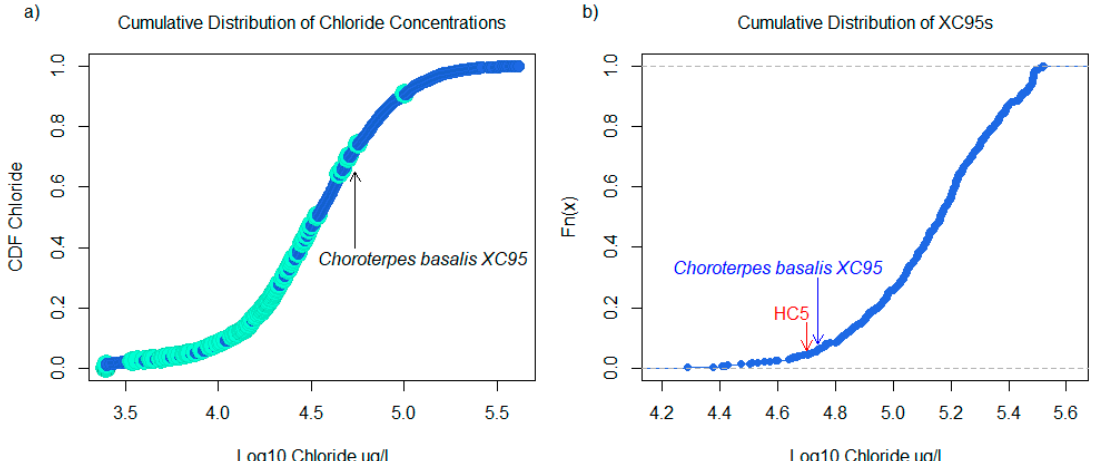
Figure 2. ( a ) The cumulative distribution of chloride concentrations from all sites. Site where the mayfly Choroterpes basalis occurs are highlighted in aquamarine and with a larger point size. The 95th percentile chloride concentration specific to C. basalis is noted as the XC95. ( b ) Cumulative distributions of XC95s for all taxa, with the XC95 for C. basalis noted. The hazard concentration (HC5) is taken as the 5th percentile from the distribution of XC95s.